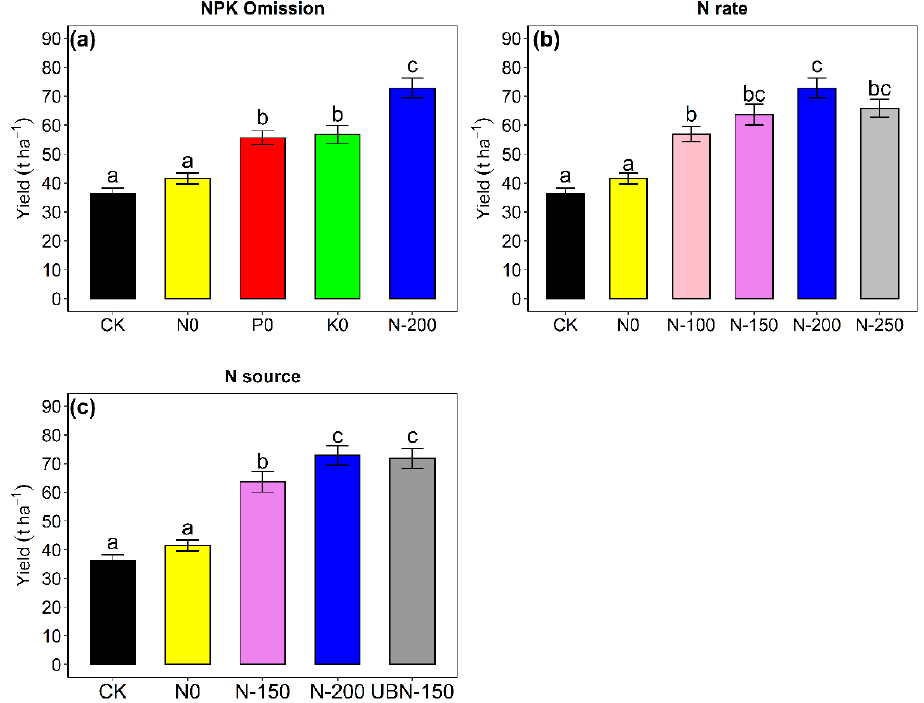
Figure 2. Average tomato yield (mean ± SE) under zero NPK ( a ), variable N rate ( b ) and N source (urea vs UB) plots ( c ): CK = control, N0 = nitrogen omission, P0 = Phosphorus omission, K0 = Potas- sium omission, N-100, N-150, N-200 and N-250 represent the N fertilizer applied at rates of 100, 150, 200 and 250 Kg ha −1 , respectively, in the form of regular urea; UBN-150 represents the urea briquette fertilizer applied at 150 kg N ha −1 . Different letters inside a bar denote significant differences between the treatments (post hoc Tukey test, p < 0.05).